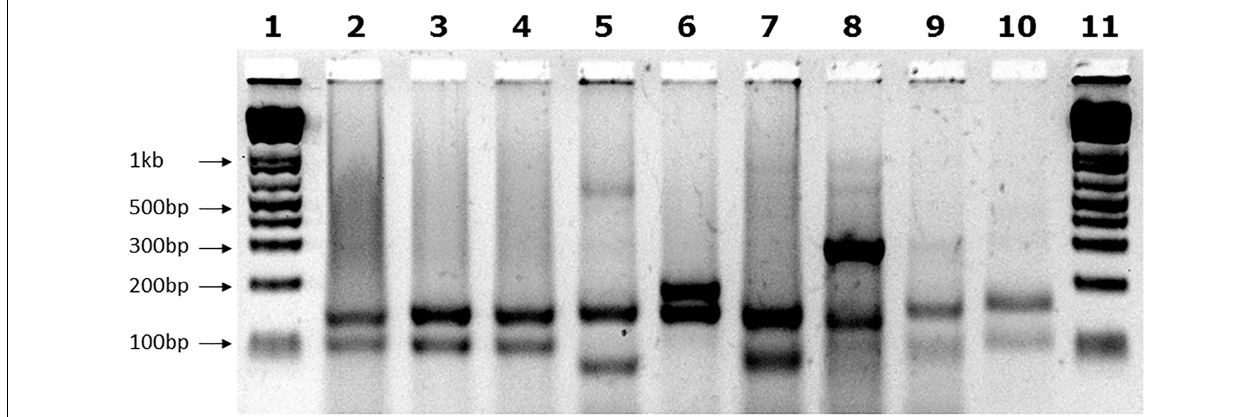
FIGURE 1 | Mbo II digest results. Agarose gel showing Mbo II digests of GAA PCR products of FRDA samples. The expected 170bp (5 (cid:48) ) and 120bp (3 (cid:48) ) undigested GAA-flanking fragments from normal pure GAA repeat expansion FRDA samples are shown in lanes 2, 3, and 4. These band sizes can be seen in between the 200 and 100bp fragments of the 1 Kb+ DNA ladder markers, which are loaded into lanes 1 and 11 of the gel. Lane 5 shows a large Mbo II band of approximately 600bp that was obtained from the positive interrupted GAA repeat sequence from the “NEP” BAC transgenic mouse that contains approximately 500 triplet repeats with the previously determined interrupted sequence of (GAA) 21 (GGAGAA) 5 (GGAGGAGAA) 70 (GAA) n (Holloway et al., 2011). In addition for this positive sample, we also identified the expected 5 (cid:48) flanking band of 170bp, together with a smaller band of less than 100bp that we sequenced and we showed to contain a 27bp deletion in